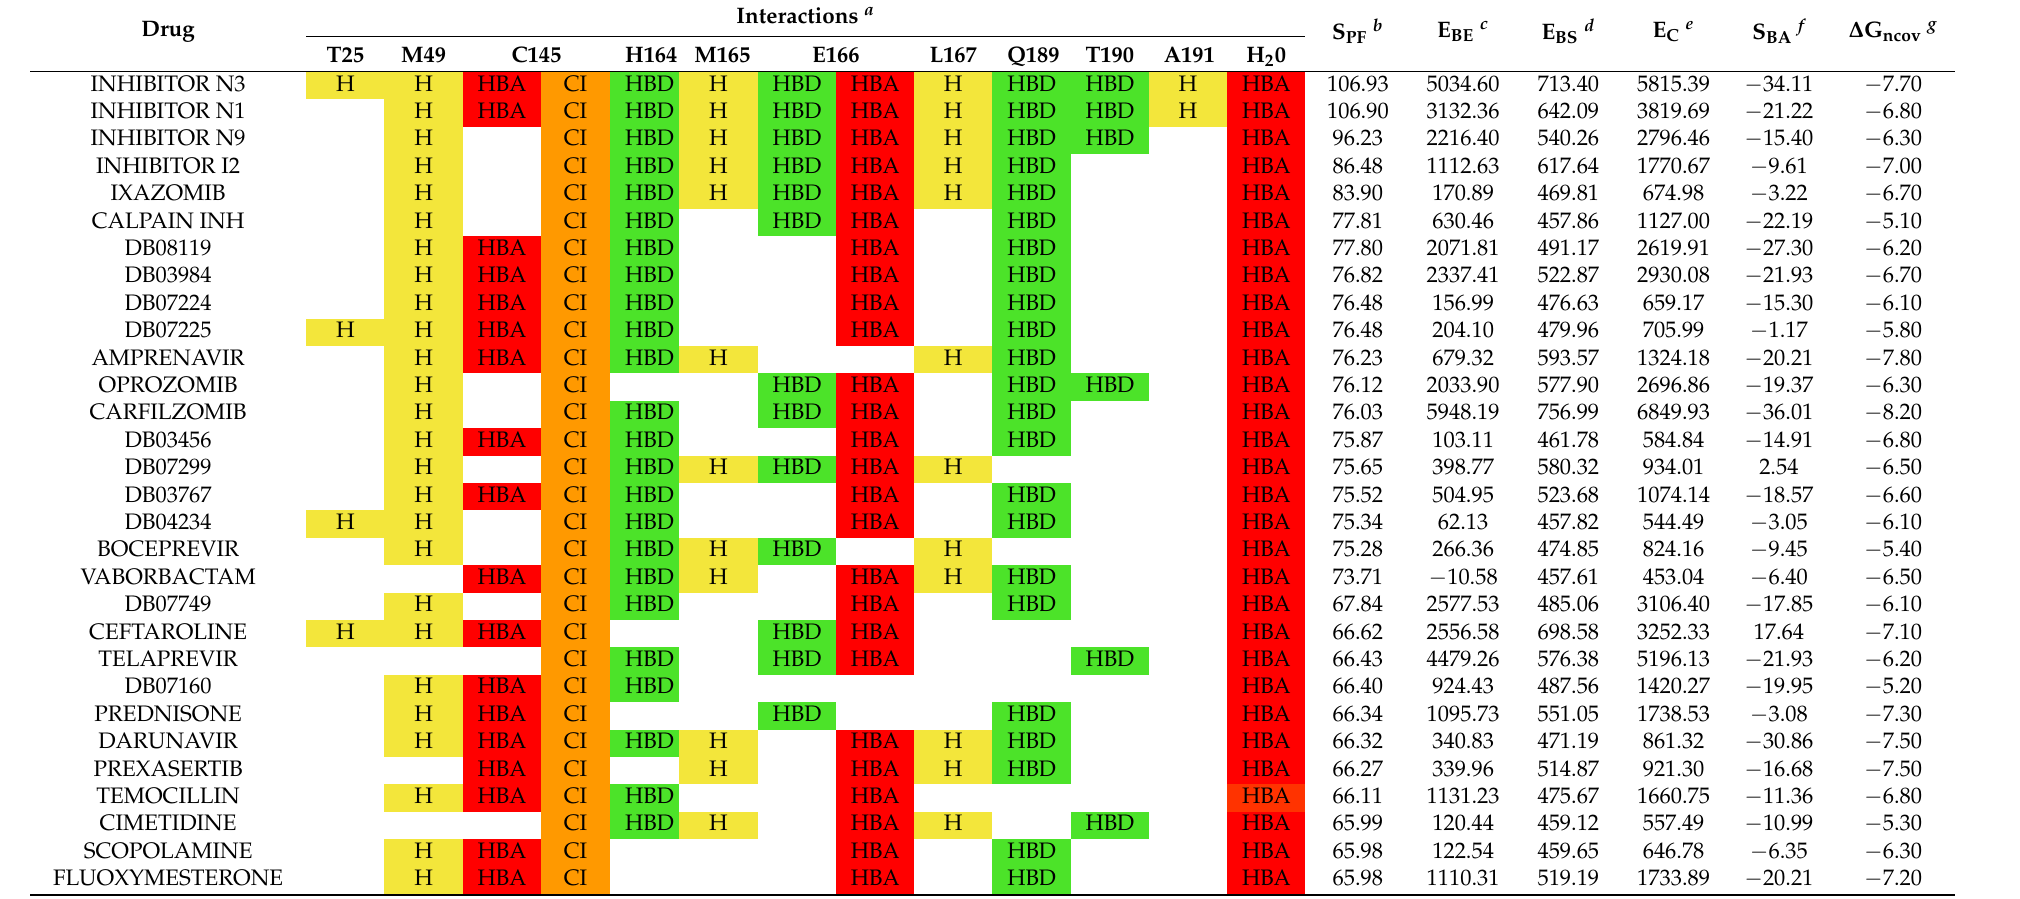
Table 1. Top-ranked DrugBank and FDA drugs from structure-based virtual screening of SARS-CoV-2 M pro .